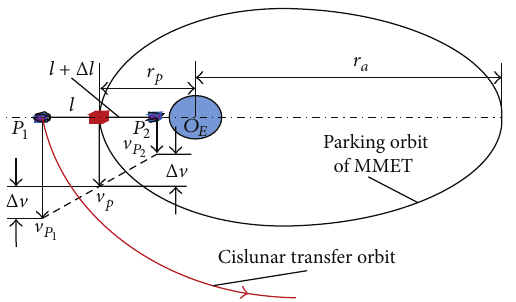
Figure 25: Schematic of payloads cislunar transfer at